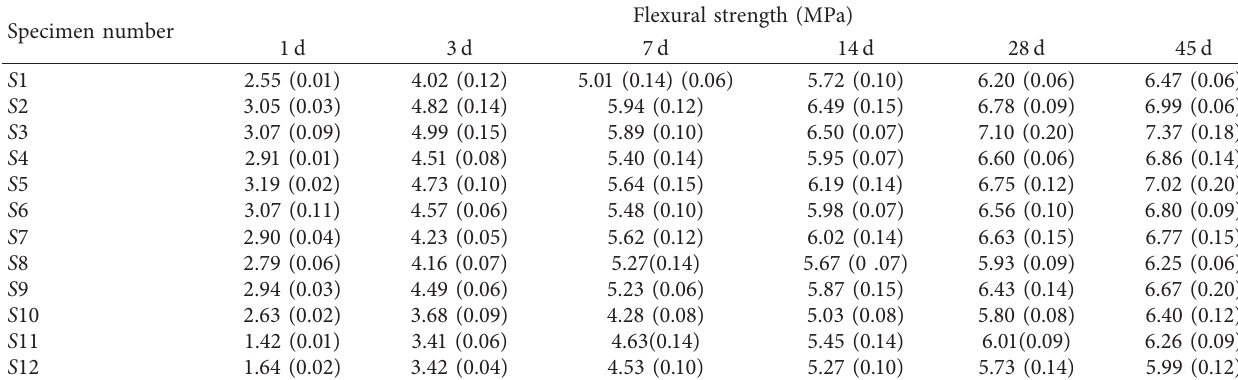
Table 4: Flexural strength of concrete at various ages.